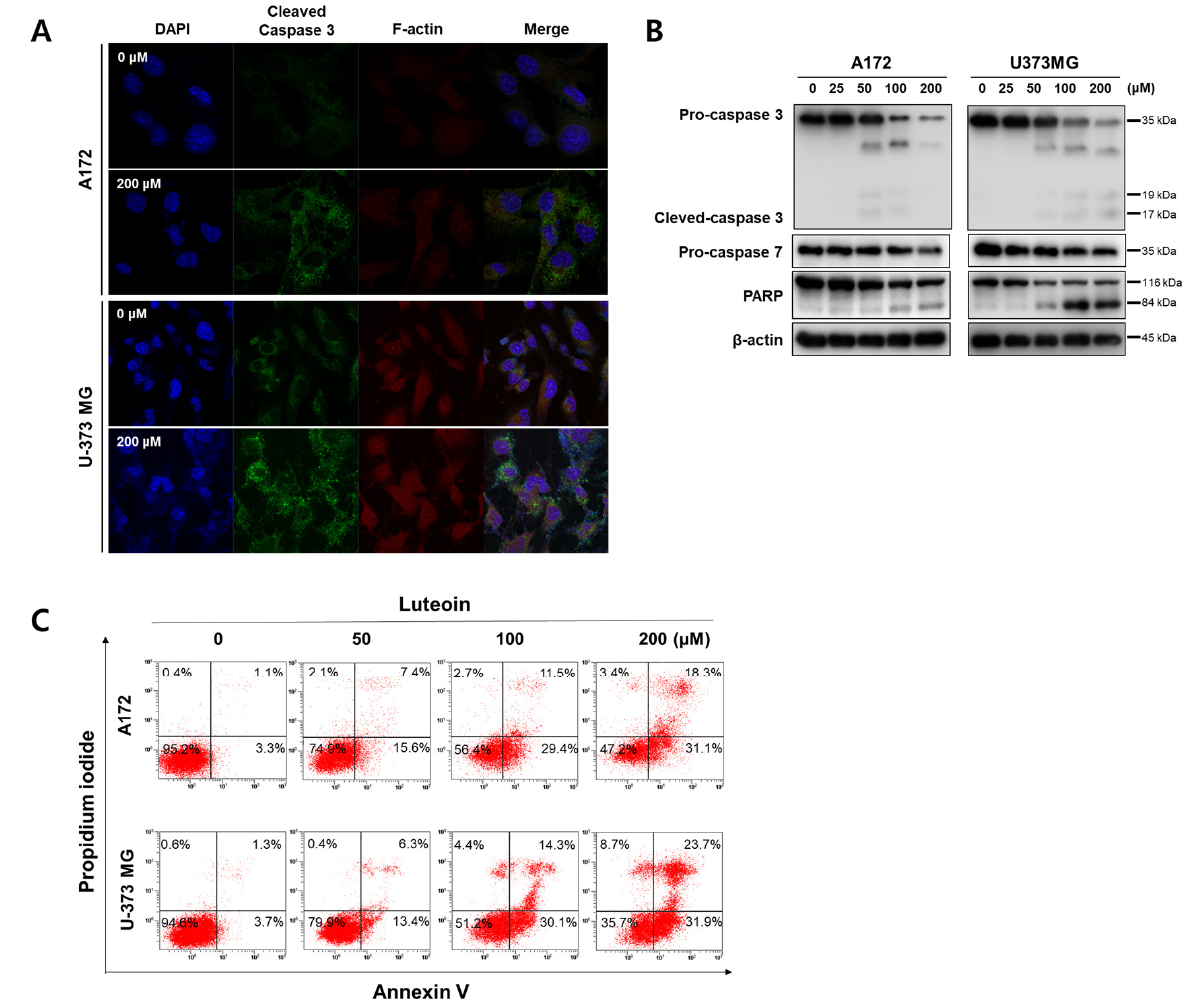
Figure 3. Induction of apoptosis by luteolin A172 and U-373MG cells. ( A ) Luteolin (200 µ M) activates cleaved caspase-3 in both GBM cells, as confirmed by immunocytochemistry using confocal microscopy. ( B ) Luteolin (0–200 µ M) treatment activated caspase-3 and caspase-7 and cleaved PARP. The protein expression levels were detected by Western blot assay. β -actin was used as internal control. (C ) Apoptotic cell populations detect by Annexin V/PI staining in luteolin-treated GBM cells.